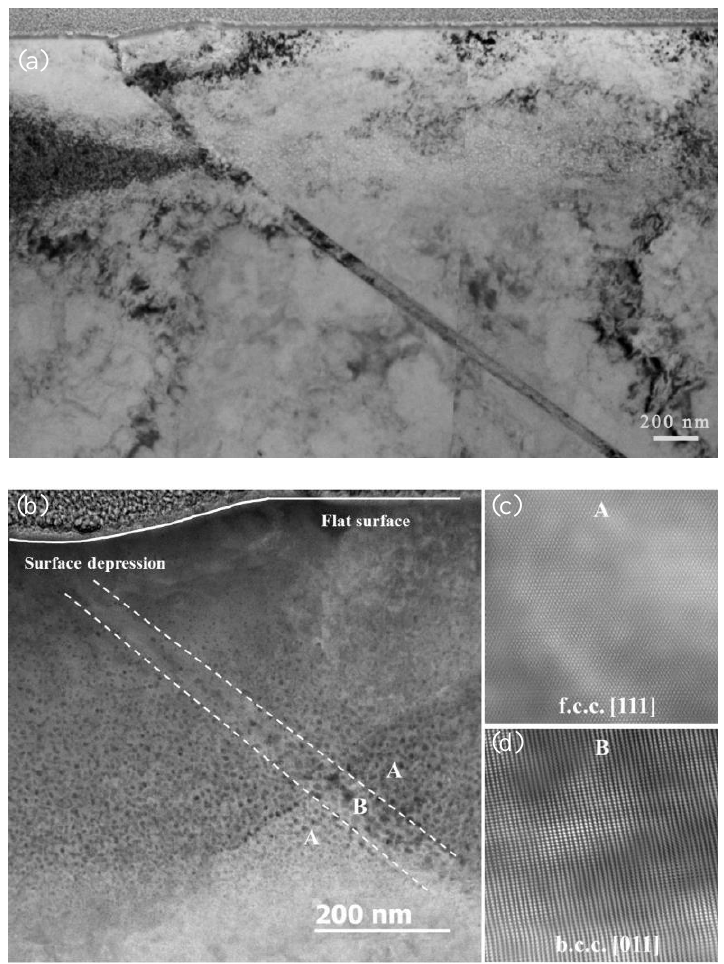
Figure 3. TEM images of the microstructure of the Fe-15Ni-15Cr alloy cryogenically treated at 77 K and heated to 773 K for a 2 × 10 17 ions cm −2 He + irradiation—showing α’ martensite lath that formed with the <110> direction. The surface depression is related to the martensitic reverse transformation. ( a ) TEM micrograph showing a martensite lath in matrix, ( b ) STEM micrograph show helium